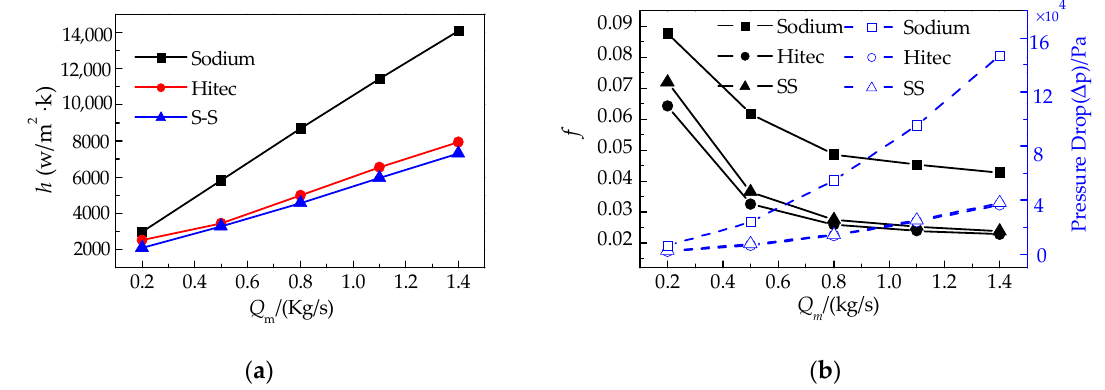
Figure 10. Effects of Q m on the heat-transfer performance of the HTFs in the tube: ( a ) Q m - h , ( b ) Q m - f - Δ p.